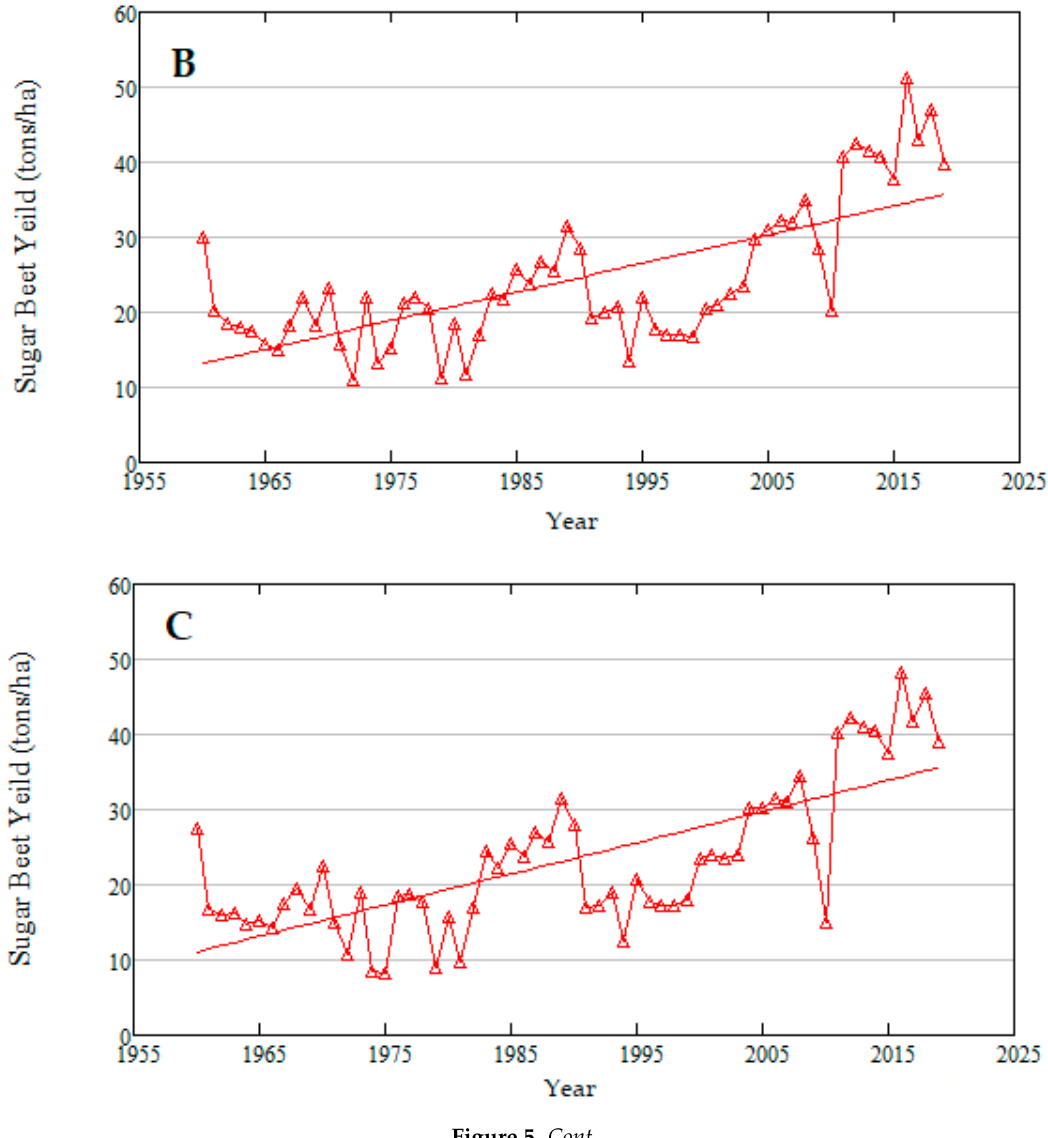
Figure 5. Figure 5. Sugar beet yield (tons ha -1 ) over the a ) northern, b ) central and western, and c ) southeastern districts within the Belgorod Region (see Fig. 4). The solid line is the regression line for each (tons ha - 1 ).